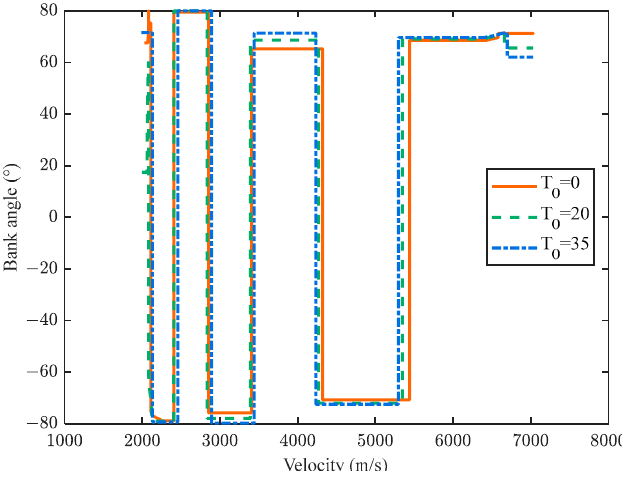
Figure 13. Velocity histories of the bank angle.